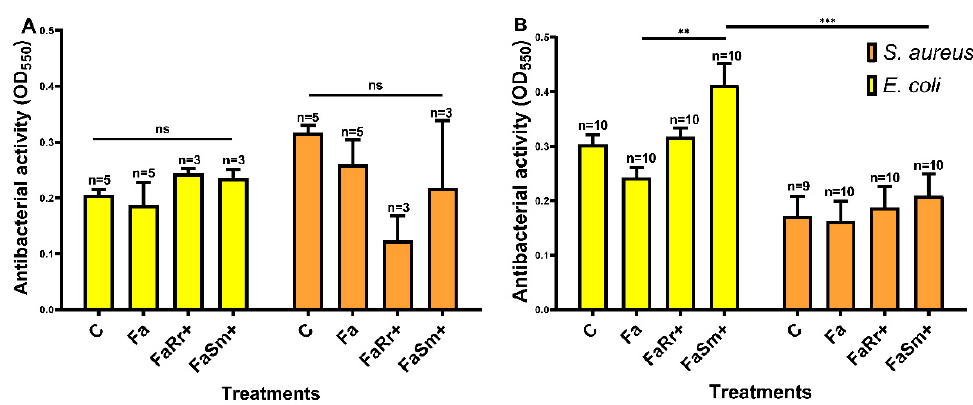
Figure 4. Antibacterial activity in the hemolymph and anterior midgut of 5th instar nymphs of Rhodnius prolixus 7 days after feeding. The treatments and group names are as described in Figure 1. The antibacterial activities were measured in vitro using ( A ) hemolymph and ( B ) anterior midgut, samples tested against E. coli (yellow bars) and S. aureus (orange bars) through the turbidimetric assay (OD 550 nm ) after 15 h incubation. Bars represent the mean ± SEM of two independent experiments with pools of 10 insects each; for each condition tested, n is represented above the bars. Means were compared between the different treatments (C, Fa, FaRr+ and FaSm+) and the different bacteria ( E. coli and S. aureus ) using two-way ANOVA with the post-hoc Tukey test; ** p < 0.01; *** p < 0.001; ns: not significant.